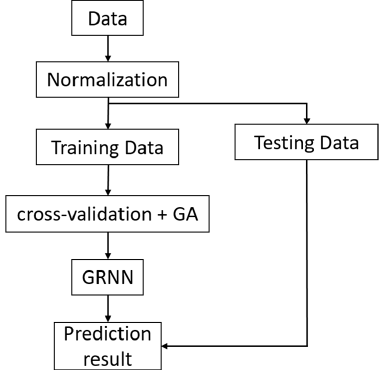
Figure 1. General Regression Neural Network architecture used for a Wafer-Handling Robot Arm.